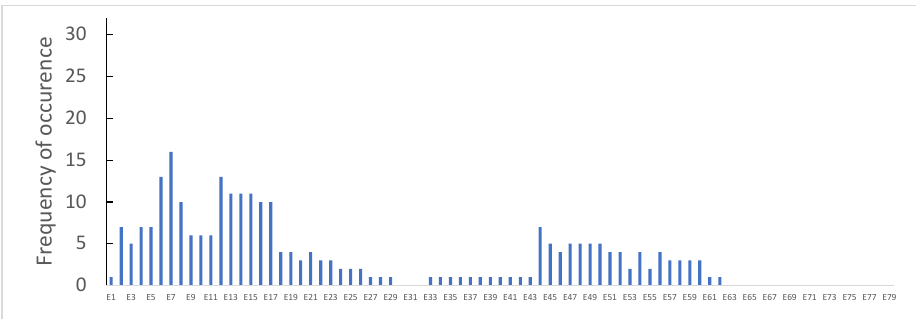
The exons most frequently duplicated were E2 and E44 in 27.8% and 22.2% of cases,